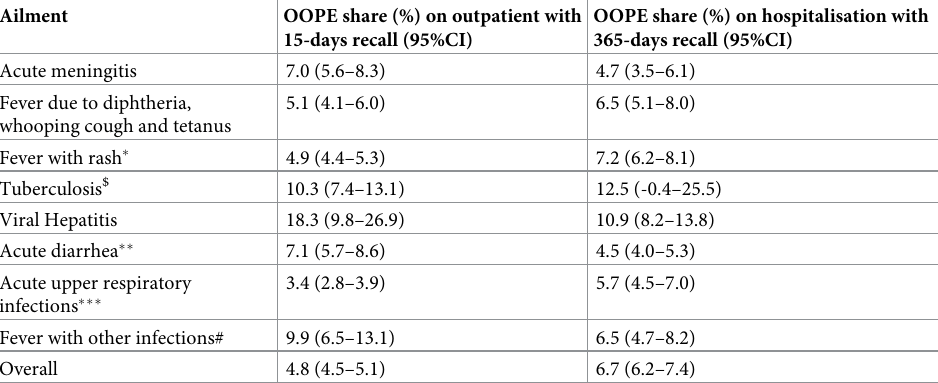
Table 4. Average share of household expenditure incurred on childhood infections (age 0–5 years) in outpatient and hospitalization.